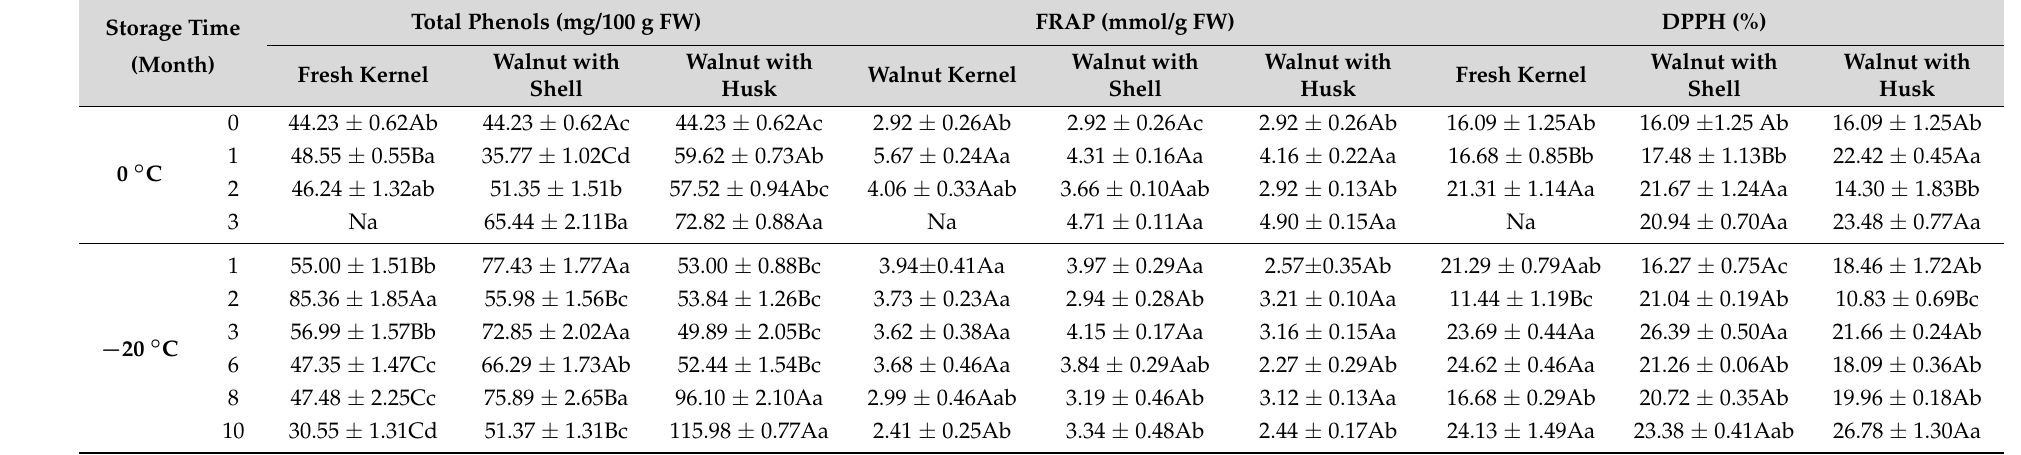
Table 1. Total phenols content and antioxidant activity of walnut kernels during the storage of 0 ◦ C (a) and − 20 ◦ C (b). Note: Na means not available. Values with different lowercase letters in the same column ‘a–d’ and uppercase letter ‘A–C’ in the same row are significantly different ( p < 0.05) from each other during